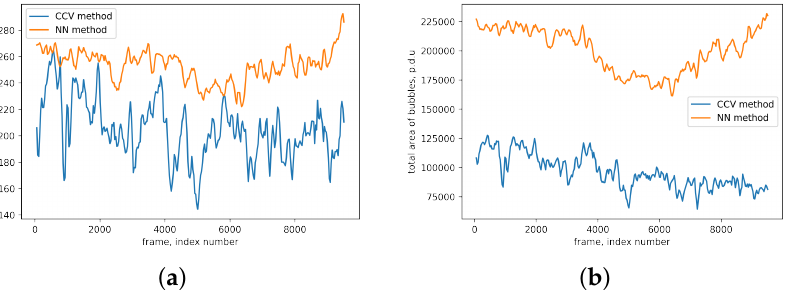
Figure 32. Comparison of the results of the classical computer vision (blue) and neural network (orange) methods for ( a ) number and ( b ) total area of bubbles. The number estimations seems to be close but the NN method results have lower variance. There is also a gap between the total area estimation but the CCV method shows in its turn lower variance results for this case.